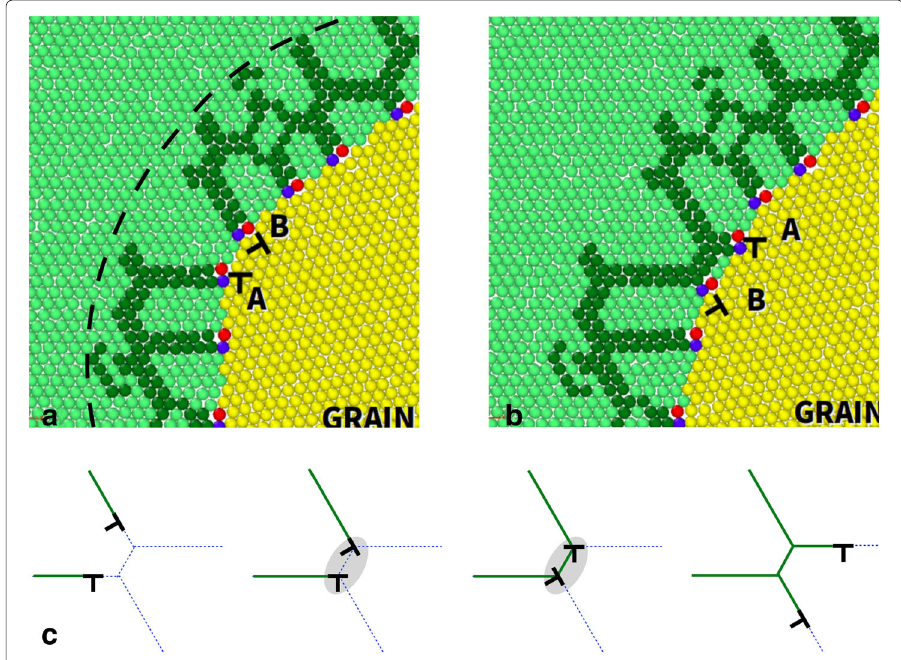
Fig. 6 Effective climb (see text). Direct interaction of two dislocations A and B with Burgers vectors [100] and √ 1 / 2[1 30]: a initial configuration; b final configuration ; c sketch of the mechanism. The dashed line indicates the initial position of the grain boundary. The color code is the same as the one used in Fig.